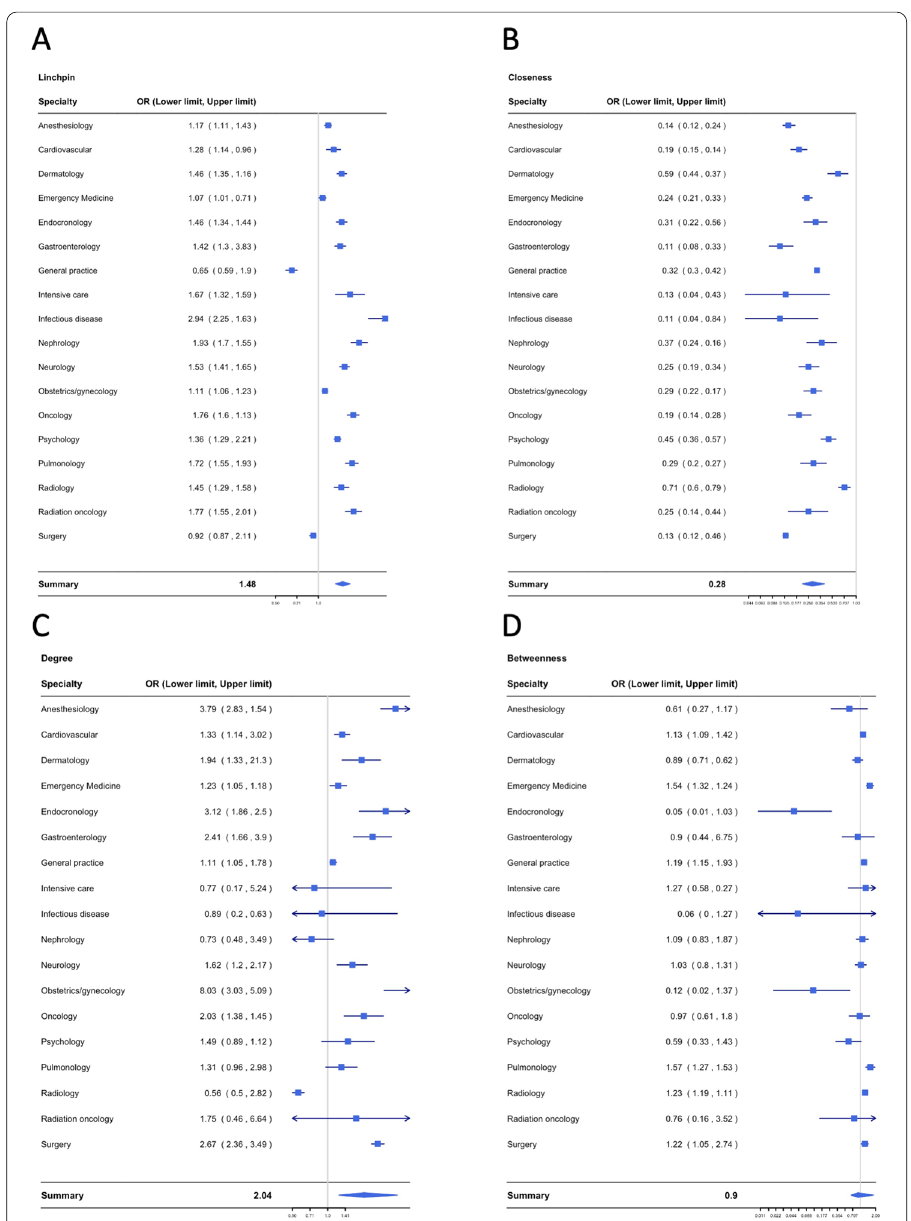
Fig. 4 Mixed effect models predicting physician rurality with linchpin ( A ), closeness ( B ), degree ( C ), and betweenness ( D ) for each specialty. Odds Ratios (ORs) and 95% confidence intervals (CIs) are shown. The gray vertical line indicates OR 1. ORs > 1 indicate that rural physicians had higher values for a given network = measure. The scales across the forest plots are not